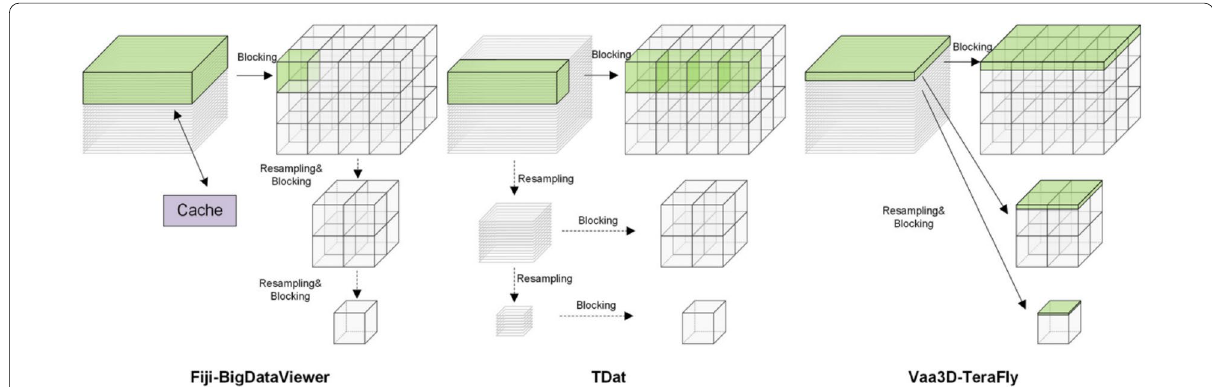
Fig. 3 Principles of different data reformatting. BigDataViewer: the green blocks in the original space represent the data to be loaded into memory. One slice is read into memory once and cached. TDat: after recursively down-sampling the original data, only a CUBOID is read into memory and split into 3D blocks. Vaa3D-TeraFly: the data is read once and transformed in to multi-resolution (adapted from Ref.